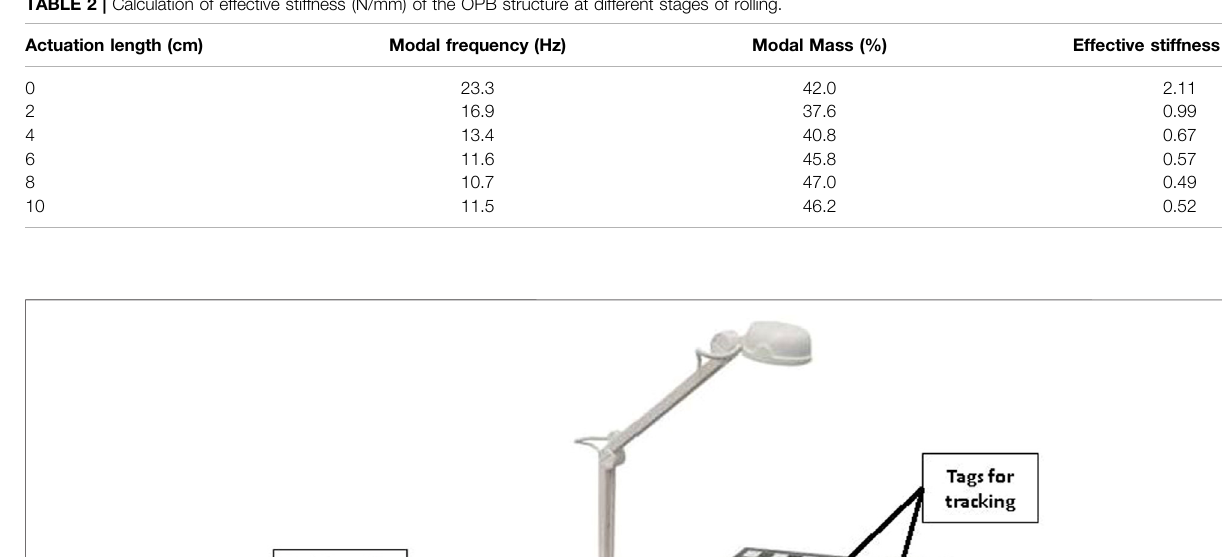
Frontiers in Built Environment |